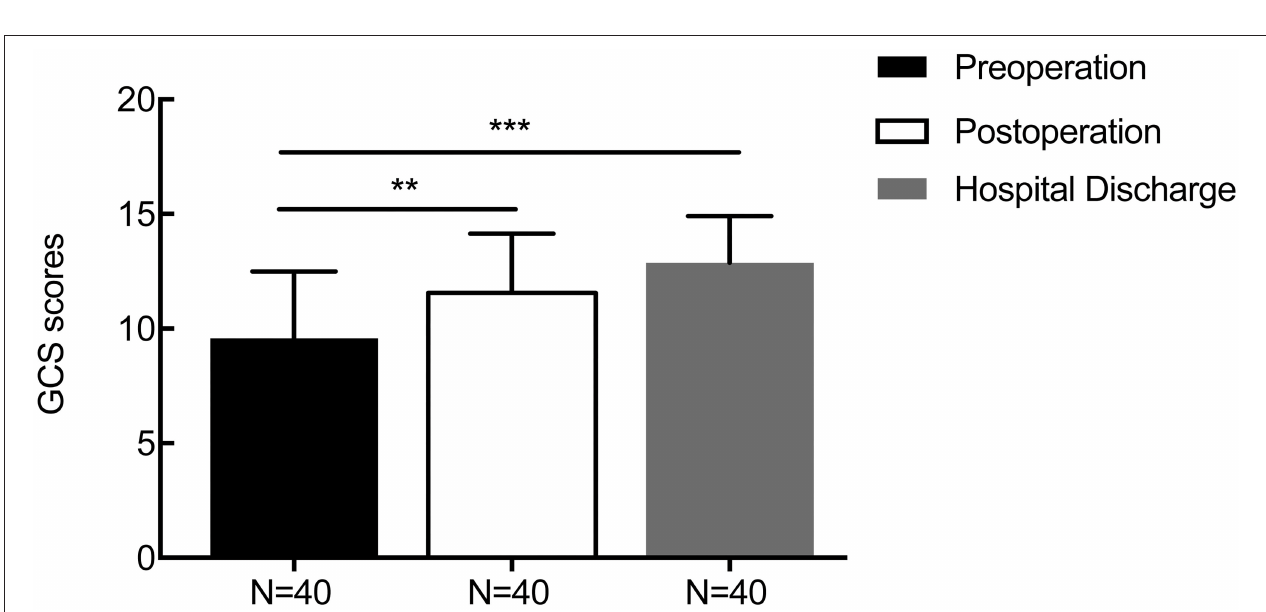
FIGURE 6 | The result of changes in the perioperative GCS score. The average initial GCS score was 9.58 ± 2.92, and the mean GCS scores at 1 week after the operation and at discharge were 11.55 ± 2.59 ( p = 0.006) and 12.86 ± 2.04 ( p = 0.000), respectively. ** p < 0.01 and *** p < 0.001.